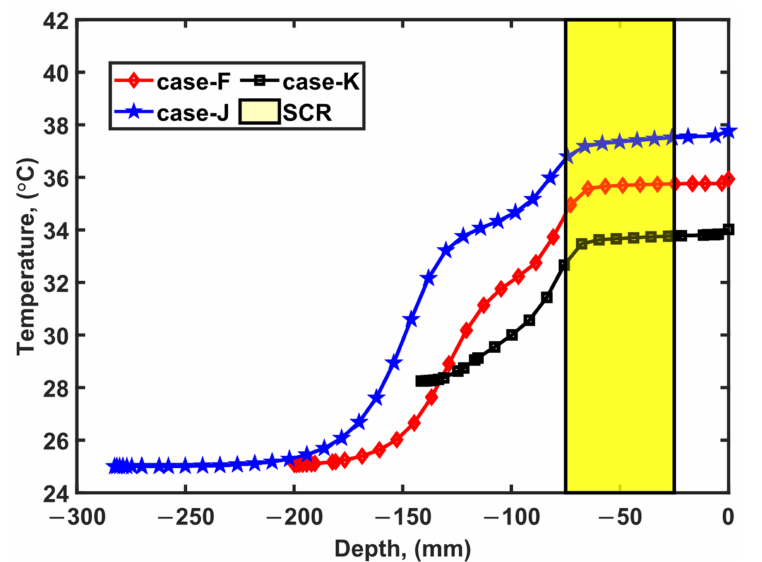
Figure 16. Thermocline at diametrically opposed ends of the SCR illustrating the influence of aspect